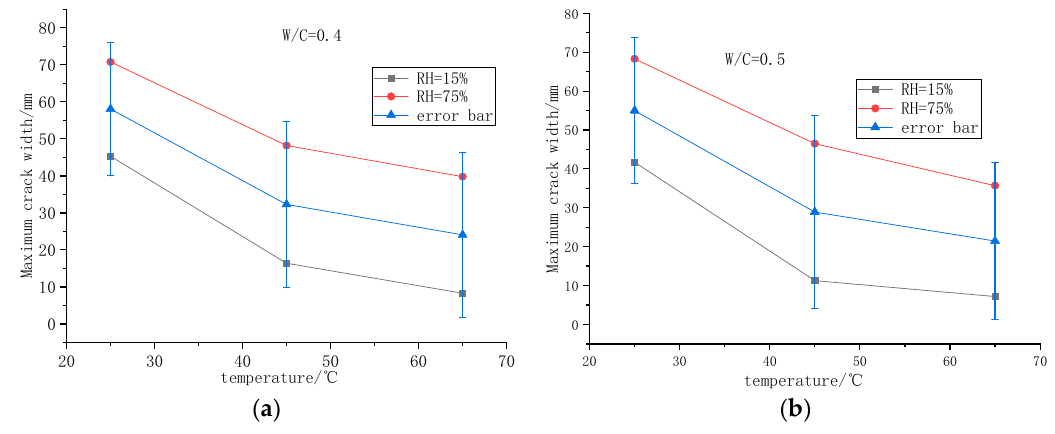
Figure 9. Initial cracking time of foamed concrete under different curing conditions: ( a ) 0.4 water–cement ratio initial cracking time of foamed concrete; ( b ) 0.5 water–cement ratio initial cracking time of foamed concrete.